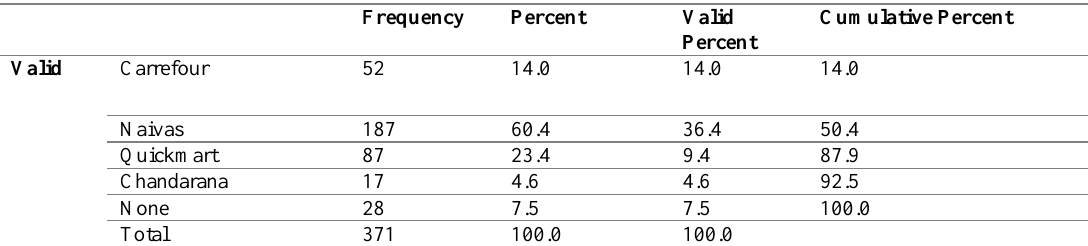
Table 9: Preferred Reward Method